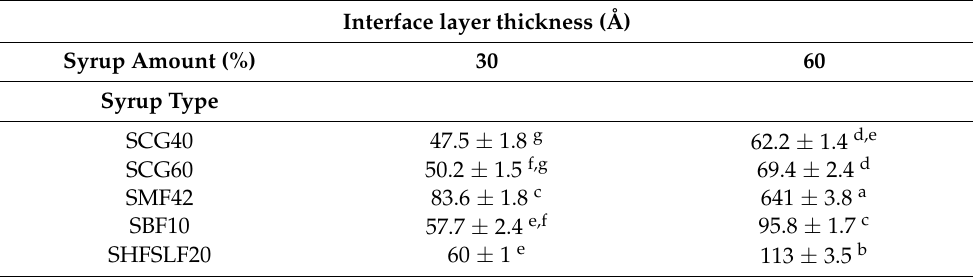
Table 2. Interface layer thickness of the soft candies calculated by Goldman–Shen pulse